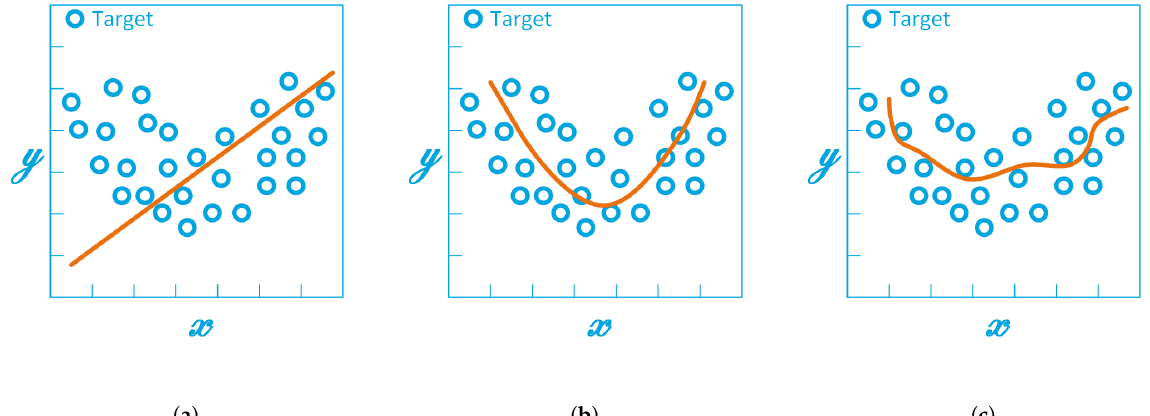
Figure A1. Different model approximations: ( a ) model with underfitting, ( b ) model with optimal fit, and ( c ) model with